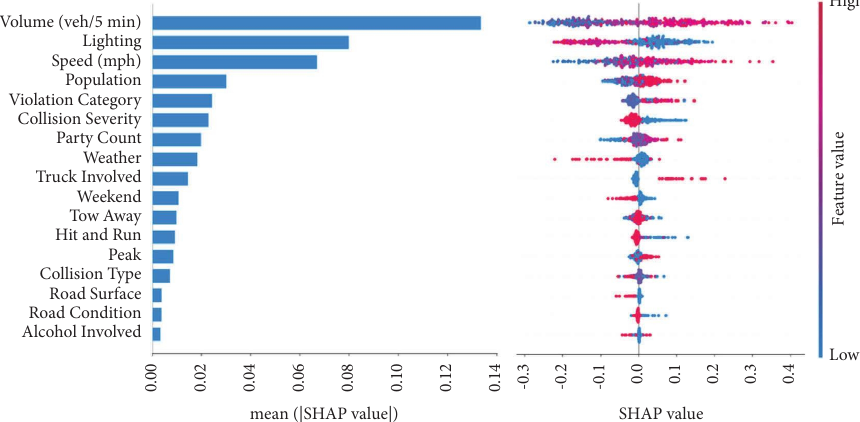
Figure 4: Global importance of independent variables and a summary of local explanations for the distance gap.